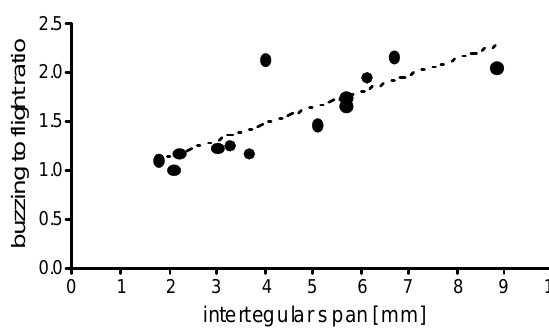
F IG . 5. Buzzing to flight ratio of the average frequencies as found in the bee species listed in Tab.2. The dotted line indicates linear regression (r² =